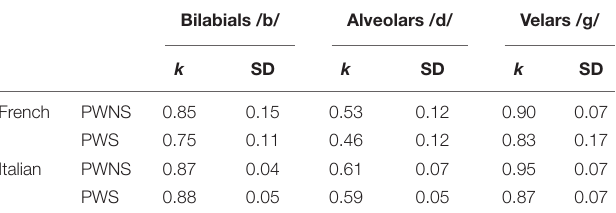
TABLE 3 | Mean values and standard deviations (SD) of k for each place of articulation in French and Italian PWNS and PWS. Bilabials /b/ Alveolars /d/ Velars /g/ k SD k SD k